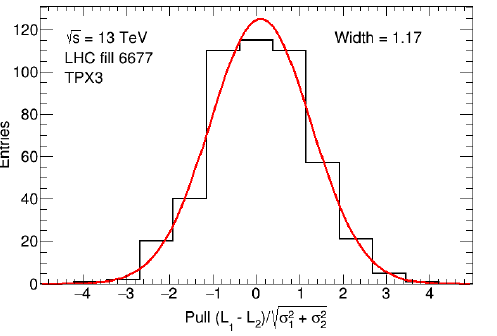
(cid:113) + σ 2 σ 2 , where σ i is the luminosity uncertainty 2 1